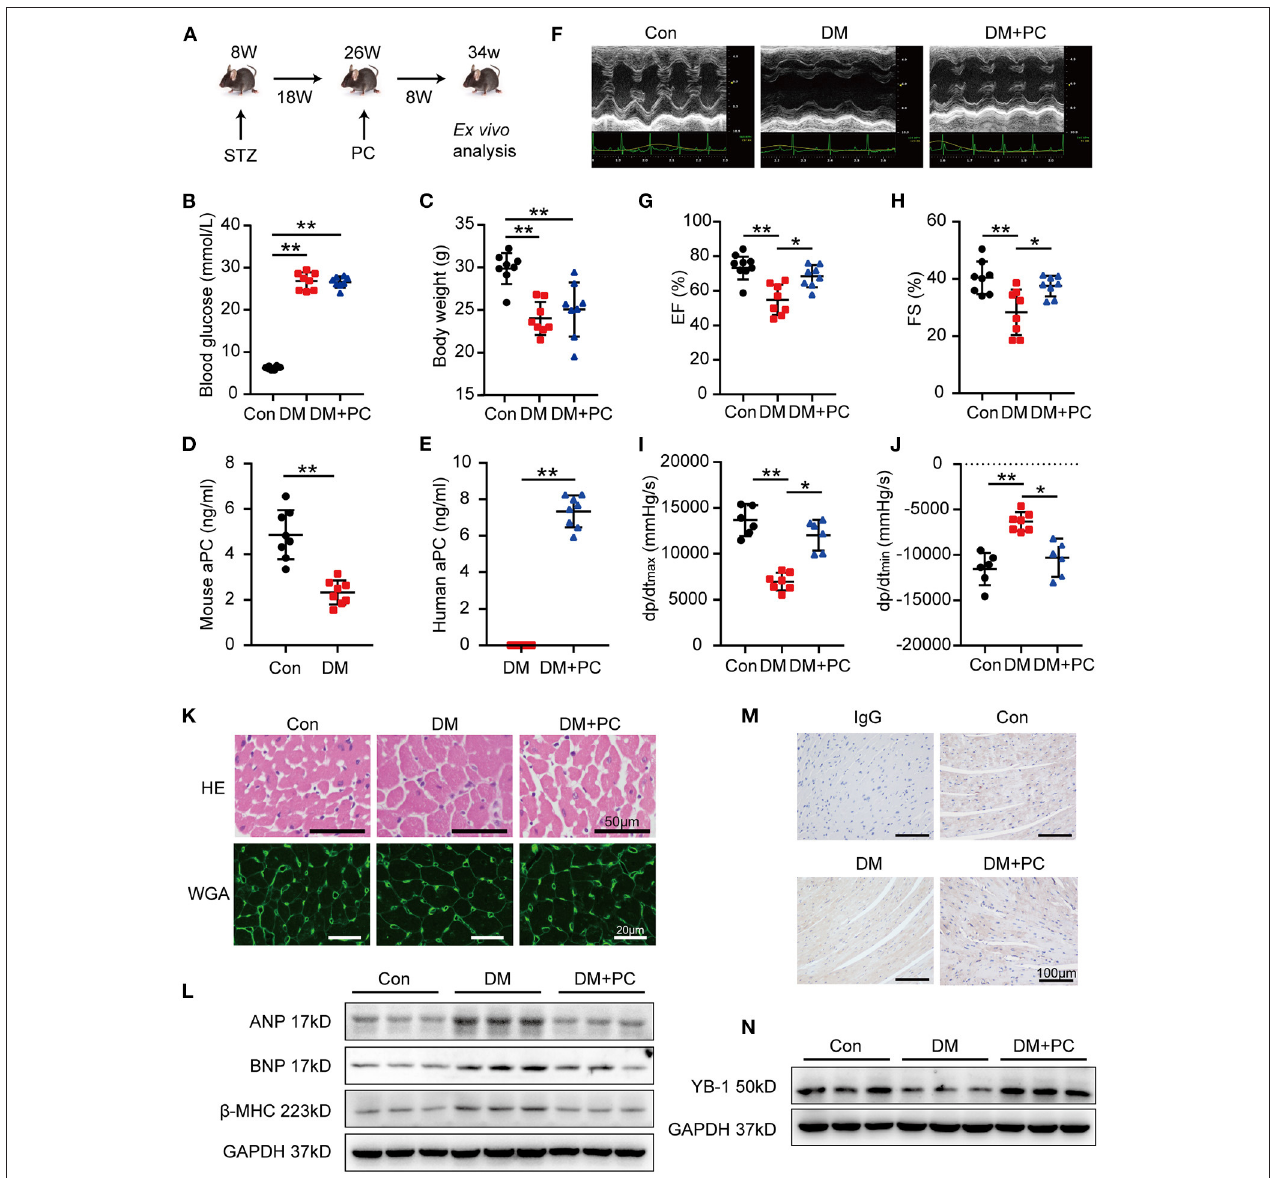
FIGURE 1 | aPC protects DCM and sustains heart YB-1 expression. (A) Schematic diagram of animal experiment procedure. DCM was induced by a 5-day continuous intraperitoneal injection of STZ at the dose of 60 mg/kg. Treatment with exogenous PC 1 mg/kg/day intraperitonially was initiated at 18 weeks post-STZ intraperitoneal injection and lasted for 8 weeks. (B) Fasting blood glucose detection. Blood glucose was detected via tail vein. (C) Body weight was measured at 34 weeks. (D) Plasma endogenous mouse activated protein C level of controls and diabetic mice. (E) Plasma human activated protein C level of diabetic mice with or without exogenous human protein C intervention. (F) Representative echocardiographic images and (G,H) scatter plot summarized results of left ventricle ejection fraction (EF) and fraction shorting (FS). (B–E,G,H) n = 8 for all the groups. (I,J) Hemodynamic analysis measured by Millar cardiac catheter system of mice. ( I,J , n = 6, Con; n = 7, DM; n = 6, DM + PC). (K) Exemplary images of hematoxylin-eosin staining (top, scale bar: 50 µ m), wheat germ agglutinin staining (bottom, scale bar: 20 µ m) of mouse hearts section. (L) Representative immunoblots showing the protein abundance of ANP, BNP, β -MHC in heart tissues from diabetic mice treated with PC or not, vs. controls. Total proteins were normalized to GAPDH. (M) Representative YB-1 immunohistochemical (IHC) staining of mice hearts tissue. Non-specific IgG served as negative control. scale bar: 100 µ m. (N) Typical western blots of YB-1. GAPDH served as loading control. Data were presented as mean ± SD. Con, control; DM, diabetes mellitus; DM + PC, diabetes mellitus with PC treatment. * P < 0.05, ** P < 0.01. t- test (D,E) or one-way ANOVA, Bonferroni comparison test (B,C,G–J) . aPC were measured via commercially available ELISA